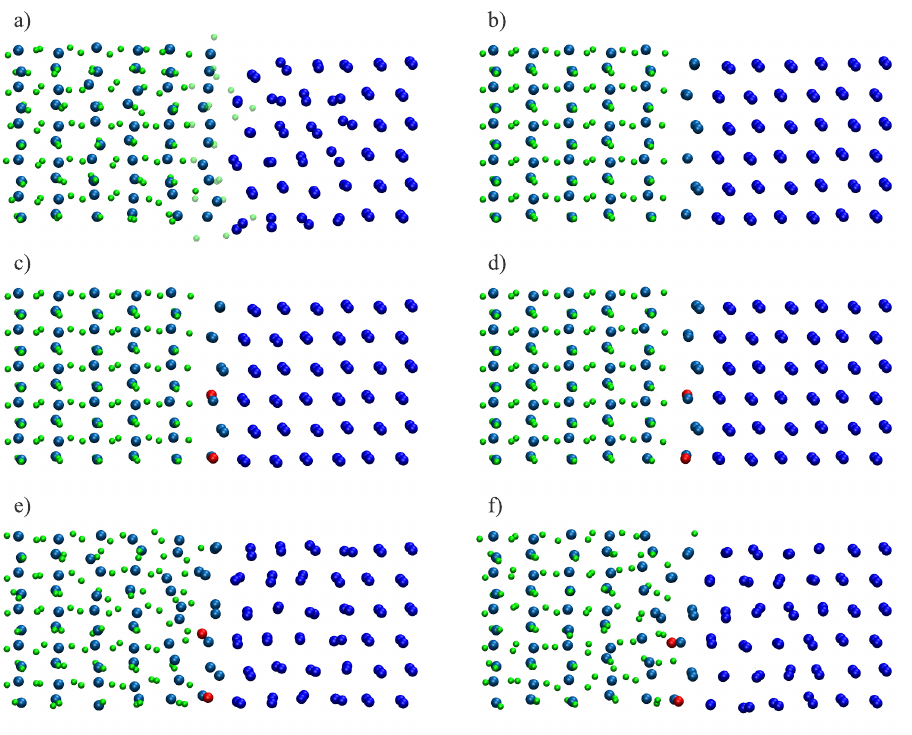
Figure 8. Snapshots for the interface reconstitution. ( a ) Final configuration of MD simulation of the interface at T = 750 K. H atoms removed are shadowed; ( b ) configuration after geometry optimization without outer hydrogens; ( c ) configuration with two Mg atoms added (in red); ( d ) configuration after geometry optimization with two Mg atoms added and reconstruction of the “new” interface; ( e ) and ( f ) two snapshots of the MD simulation at T = 750